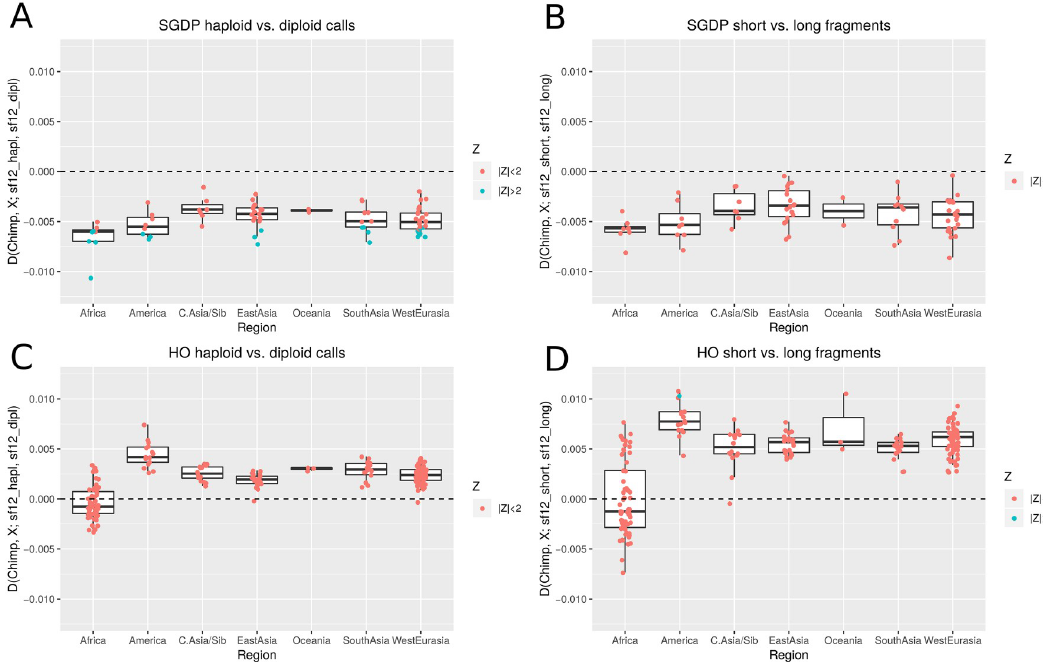
Fig 3. D statistics testing the affinity between different modern populations ( X ) and two different treatments of the high coverage individual sf12. The basis for these comparisons are the whole genome sequence data of the SGDP panel (A and B) or SNP array genotype data from the HO panel (C and D). Comparisons are done between pseudo-haploid and diploid calls for sf12 (A and C), and between pseudo-haploid calls from short (35-40 bp) or long (75-80 bp) fragments (B and D). The x axis represents the geographic origin of population X